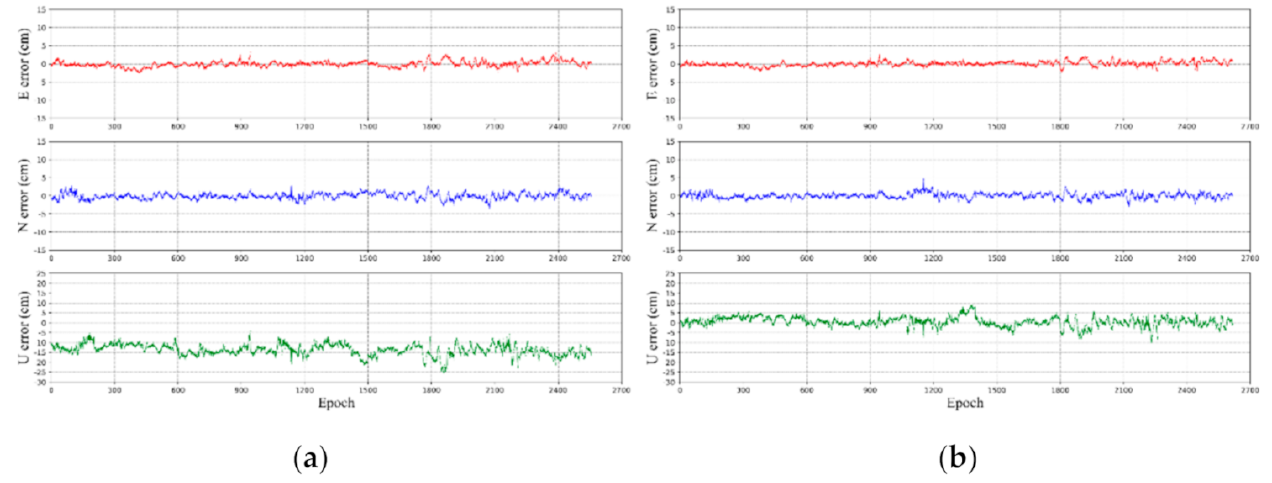
Figure 17. TLIM ( a ) and MLIM ( b ) positioning errors with respect to the epoch during the selected data period at rover